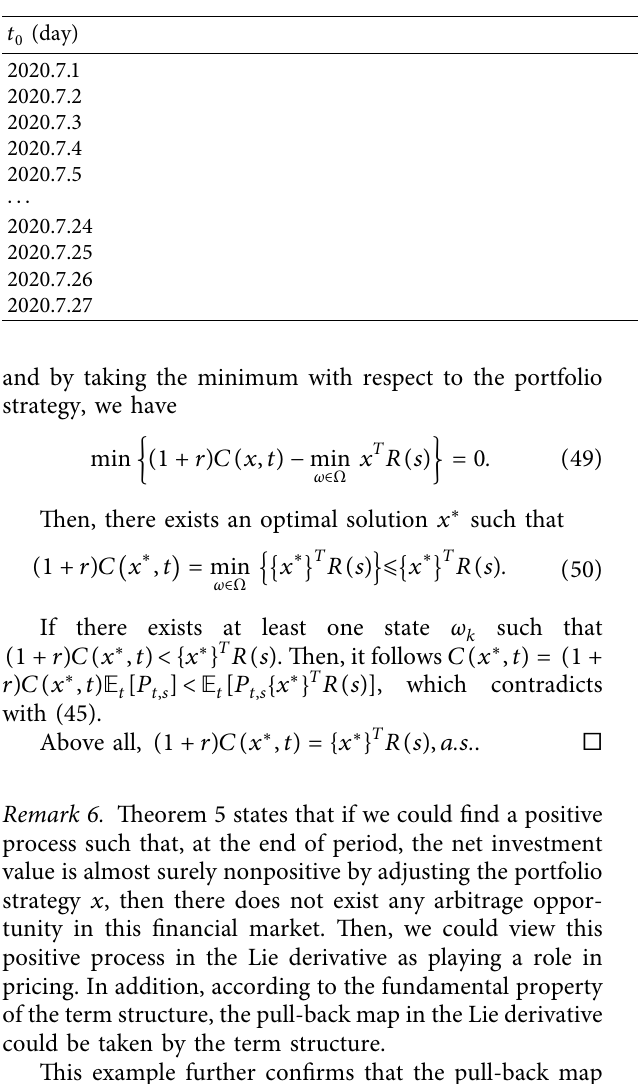
Table 3: Te value of the Lie